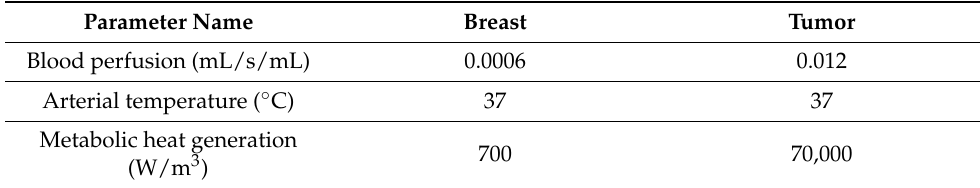
Table 2. Pennes equation parameters